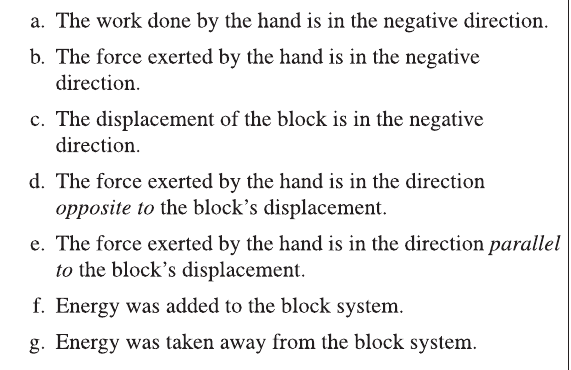
FIG. 1. PIQL MCMR item that probes understanding of the negative sign in the context of mechanical work. The correct answers are d and